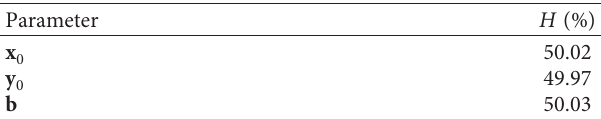
Table 4: Sensitivity